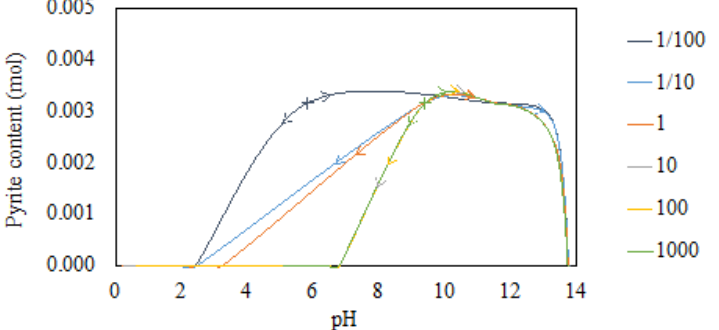
Figure 8. Models of pyrite dissolution as a function of calcite content (calcite/pyrite ratio in mol/mol) in calcite/pyrite/SiO 2 assemblage. Arrows indicate the direction of addition or depletion of protons; crosses indicate the point of equilibrium with pure water (natural pH).